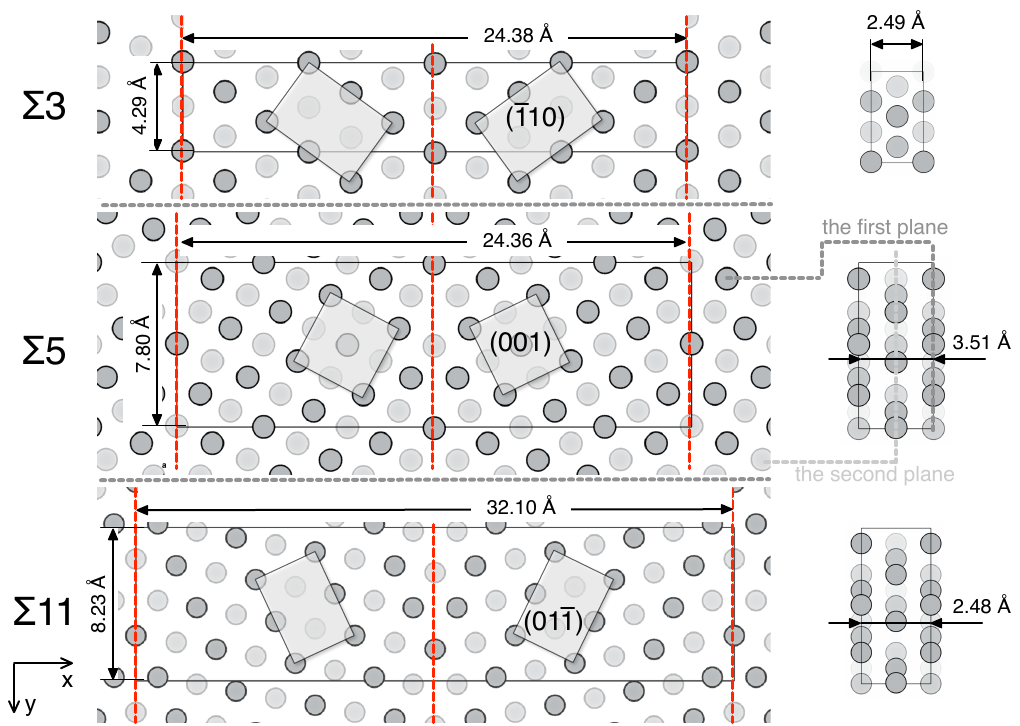
Figure 1. The supercells containing Σ 3(111), Σ 5(210), and Σ 11(311) grain boundaries (GBs) used in the present ab initio calculations. The planes perpendicular to the rotation axis related to GBs are highlighted. Orientation of the supercells were x (cid:107) [ 111 ] , y (cid:107) [ 11¯2 ] , and z (cid:107) [ ¯110 ] for the Σ 3 GB; x (cid:107) [ 210 ] , y (cid:107) [ ¯120 ] , and z (cid:107) [ 001 ] for the Σ 5 GB; and x (cid:107) [ 311 ] , y (cid:107) [ ¯233 ] , and z (cid:107) [ 0¯11 ] for the Σ 11 GB.